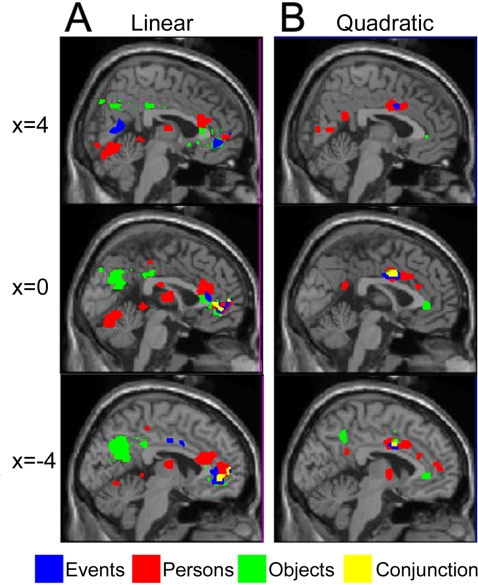
Areas in which brain activity for three stimulus categories showed parametric modulation by desirability rating (Puncorrected <0.001); (A) linear (1st order) relationship, (B) quadratic (2nd order) relationship.Activations are shown superimposed on successive sagittal sections (x = −4, 0, 4).